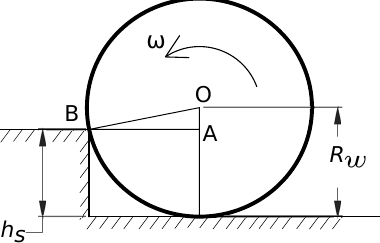
Figure 4. Schematic representation of step and wheel R w ≥ h s